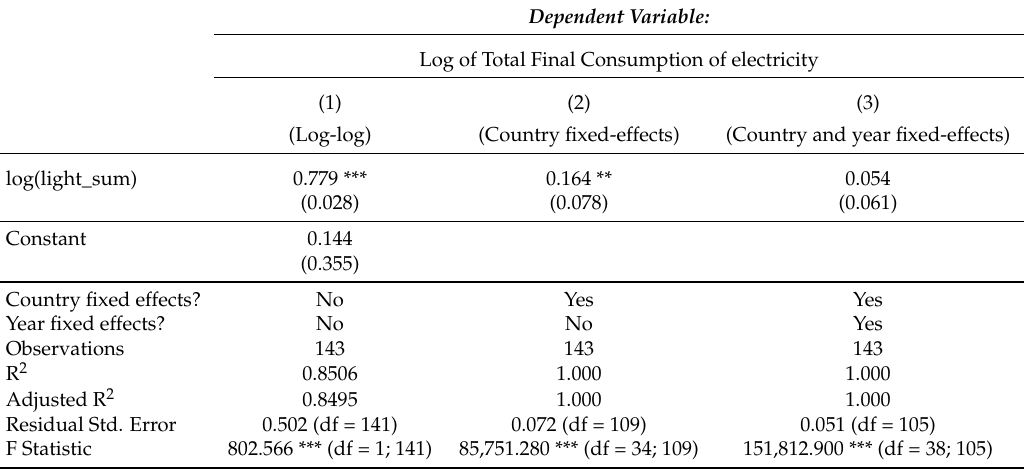
Table A8. Regression for RESIDENT—Higher-middle income countries.